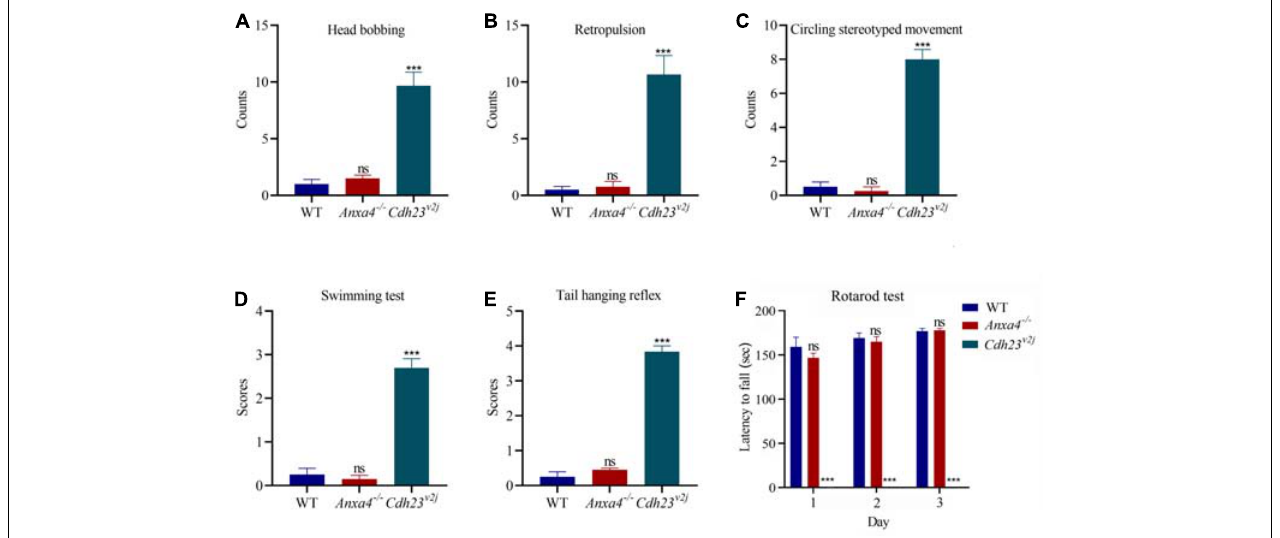
FIGURE 4 | Vestibular function is unaffected in Anxa4 − / − mice. The vestibular function of 2-month-old Anxa4 − / − and wild type mice ( n = 4) was evaluated by performing (A) head bobbing, (B) retropulsion, (C) circling stereotyped movement, (D) swimming, (E) tail hanging reflex, and (F) rotarod test. Five-month-old Cdh23 mutant mice ( V 2 J ) ( n = 3) were included as positive control. ns, not significant; *** P < 0.001.